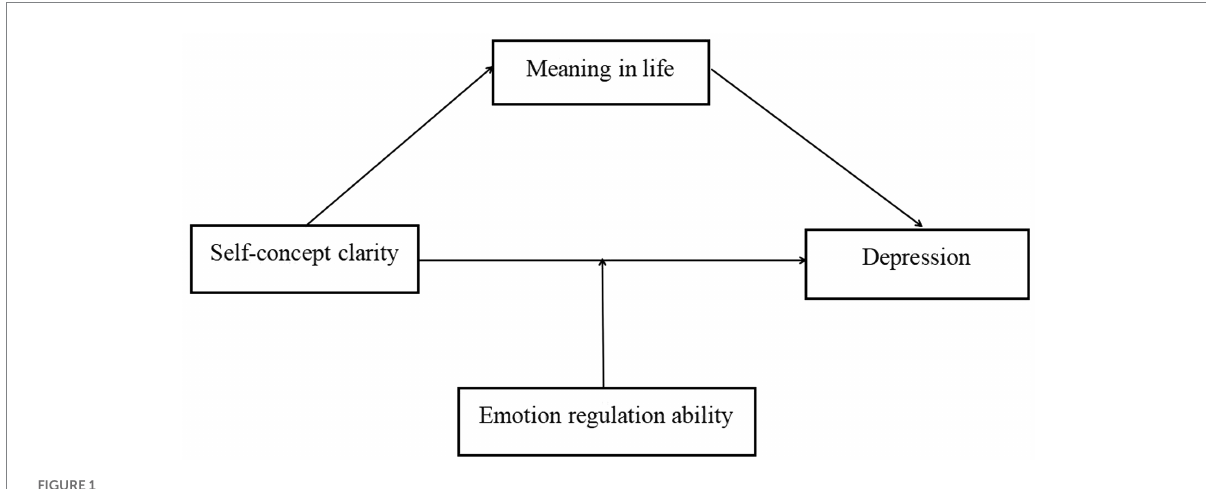
FIGURE 1 Proposed theoretical